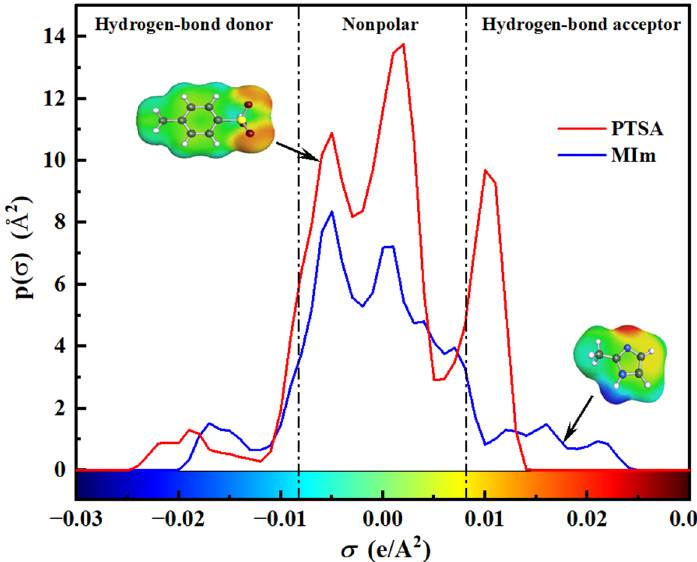
Figure 1. σ -Profiles of 2-methyl imidazole and p-toluenesulfonic acid.